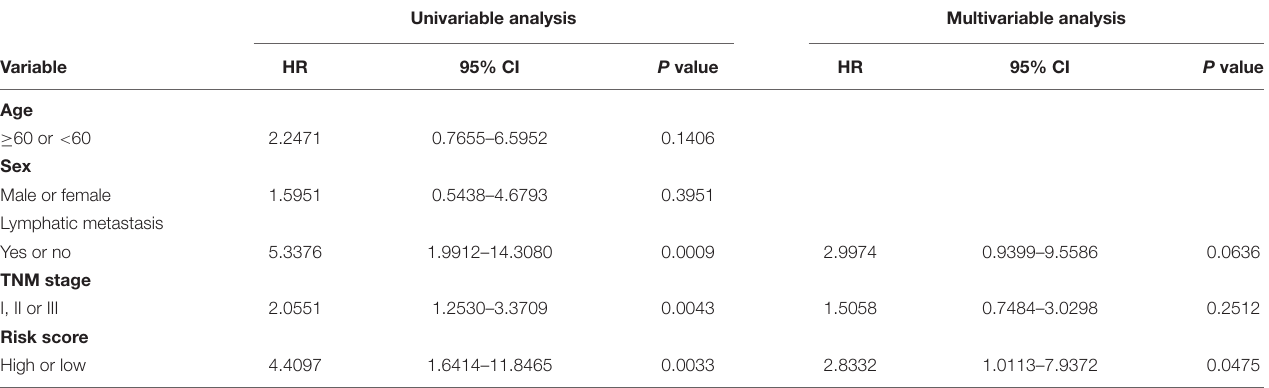
FIGURE 4 | Relationship between risk score and most relevant immune-related genes and biological pathways. (A) Details of risk score and the most relevant genes. (B) Gene enrichment with GO terms of the selected genes. (C) Gene enrichment with KEGG terms of the selected genes. Young and old represent age < 60 and age ≥ 60 years, respectively. TABLE 2 | Univariable and multivariable Cox regression analysis of the six-gene immune-related signature and overall survival in the independent validation